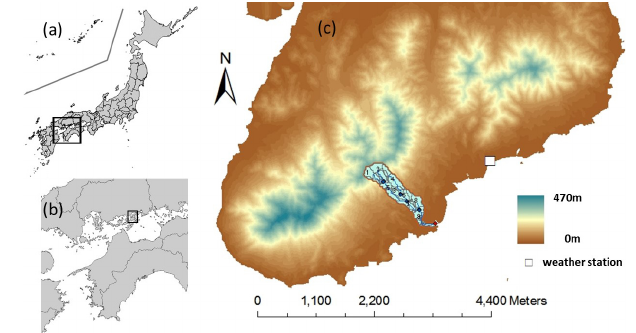
Figure 1. The research area in Japan (a) , the Central Seto Inland Sea (b) , research catchment (c) .